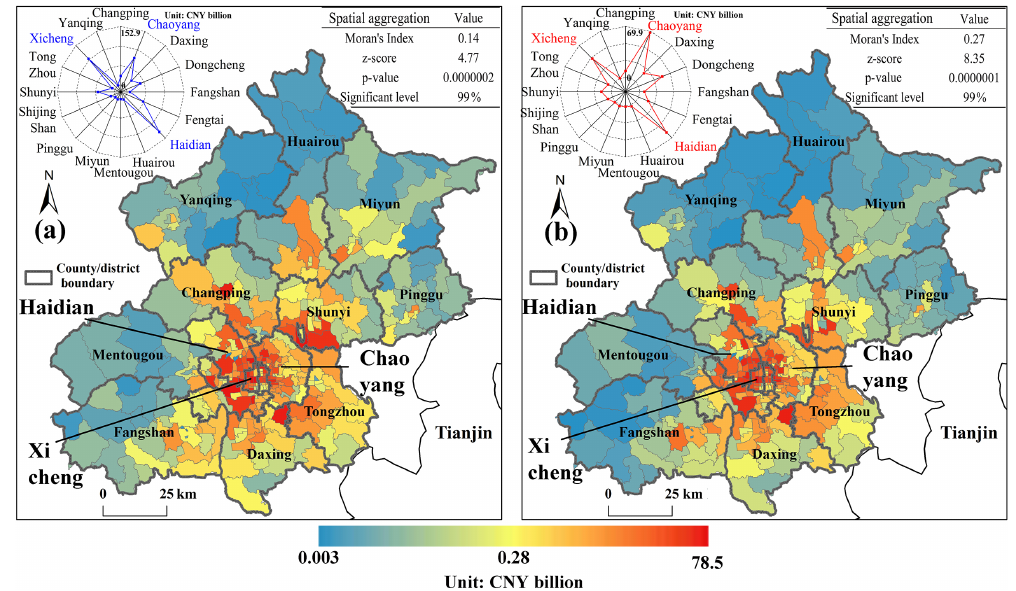
Figure 4. Spatial heterogeneity of the direct economic loss (a) and the ripple effects (b) of the indirect economic loss. The rose diagram in the upper left-hand corner of the figure represents the loss values of the districts. The table in the upper right-hand corner of figure represents the results of the spatial aggregation calculated using the spatial autocorrelation (Moran’s I) method; the global Moran’s I is an index used to measure spatial correlation, which is more obvious when its value is closer to 1. The z score and p values are used to judge the confidence coefficient level; the results show that both of the spatial aggregations of DEL and IEL exceed the 99% confidence